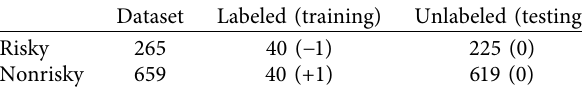
Table 1: Sample distribution of dataset.